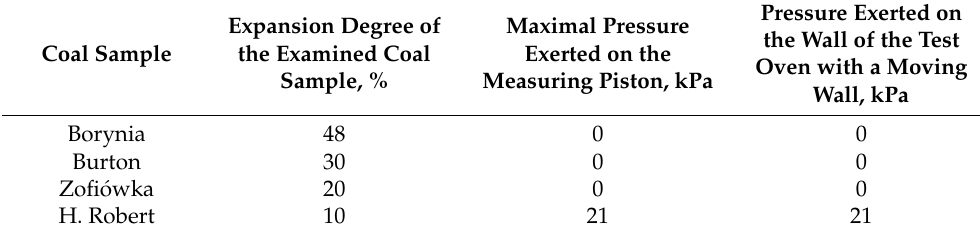
Table 7. Comparison of the coking pressure measured in the laboratory equipment under conditions of the expansion corresponding to the shrinkage determined by the Sapozhnikov method with the wall pressure measured in a test oven with a moving